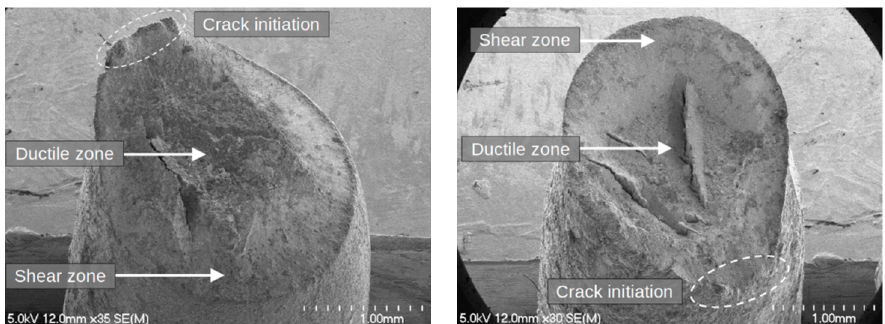
Figure 17. Tensile test fracture surface of an intermediate corroded steel wire (168 days, individual steel wire, UTS = 10.53 kN, total deformation = 3.63%).